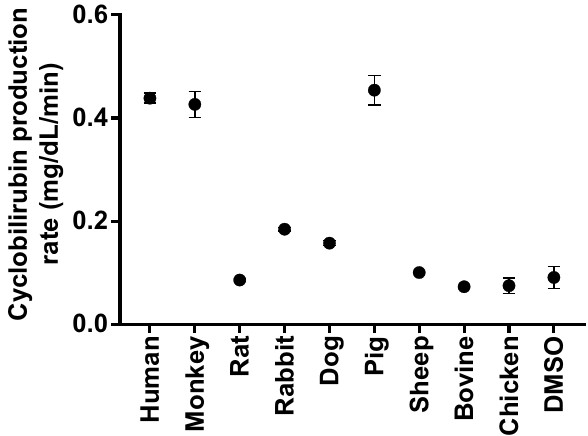
Figure 1. Cyclobilirubin production rate. The cyclobilirubin production rate at 3 min after irradiation. Cyclobilirubin is the sum of (EZ) -cyclobilirubin and (EE) -cyclobilirubin. Each closed circle and error bar represent the mean ± SD. DMSO, dimethyl